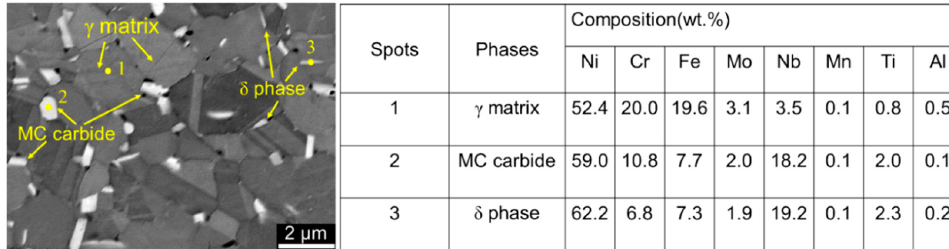
Figure 7. BSE SEM micrograph of S950 + DA sample showing a number of EDS point scans, and their respective chemical compositions of the various phases.